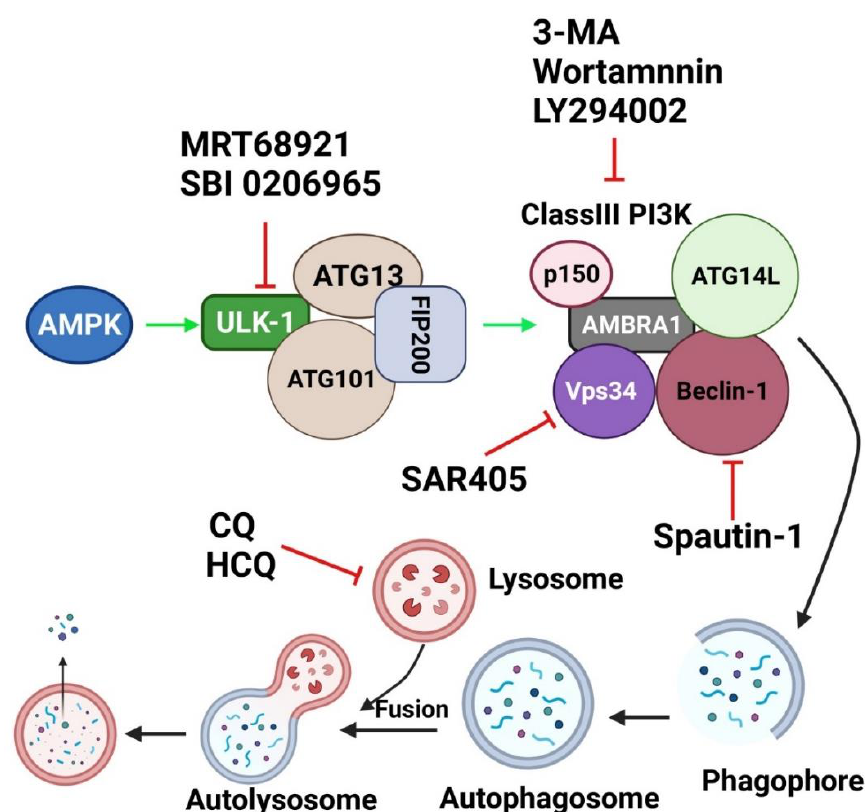
Figure 3. Autophagy Inhibitors and their site of action in autophagic machinery. MRT68921 and SBI-0206965 are ULK-1 inhibitors. 3-MA, Wortmannin and LY294002 are Class III PI3K inhibitors. Spautin-1 is a Beclin-1 inhibitor and SAR405 is a Vps34 inhibitor. Chloroquine (CQ) and hydroxyl chloroquine (HCQ) are late autophagy inhibitors which target lysosomal pH rendering the fusion between autophagosome and lysosome. Green arrow indicates activation and red arrow indicates inhibition. Created with BioRender.com (accessed on 15 October 2021).